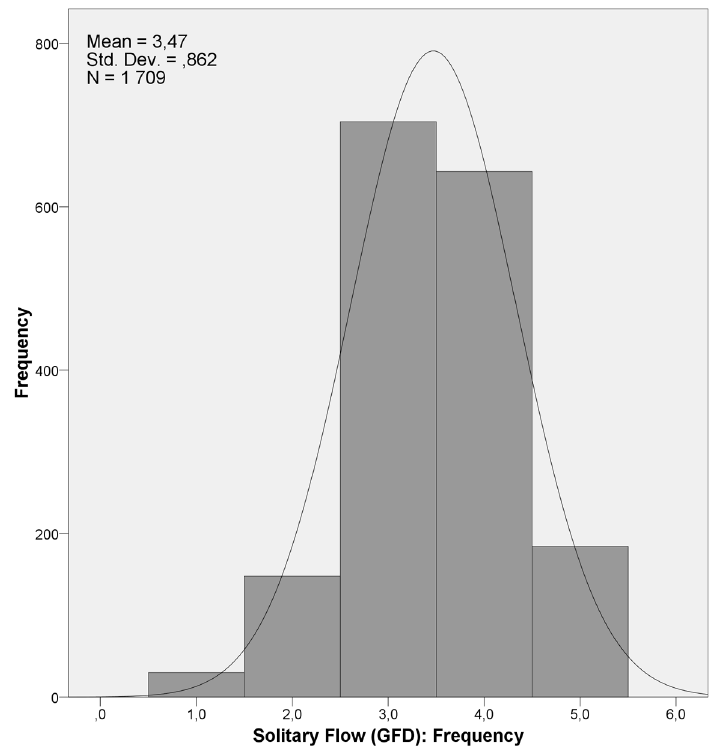
Figure 1. Histogram of the frequency of solitary flow experience